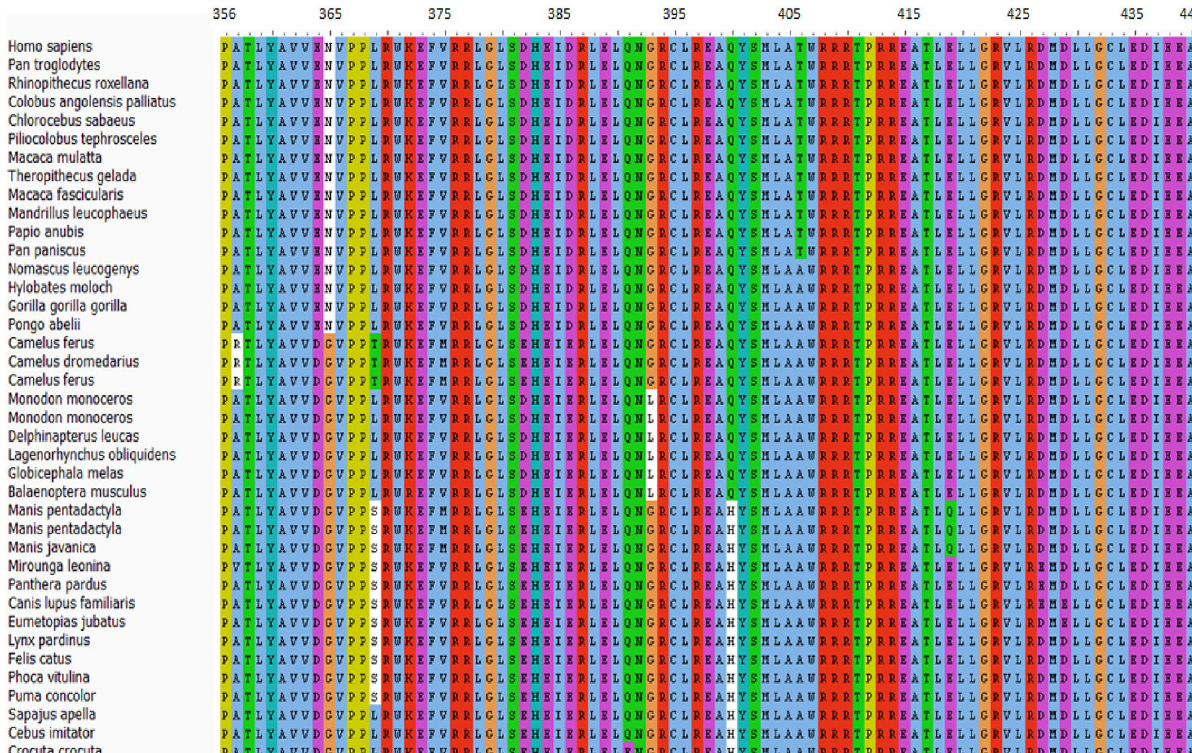
Figure 2. Residue conservation pattern of TNFR1 death domain in selected organisms.